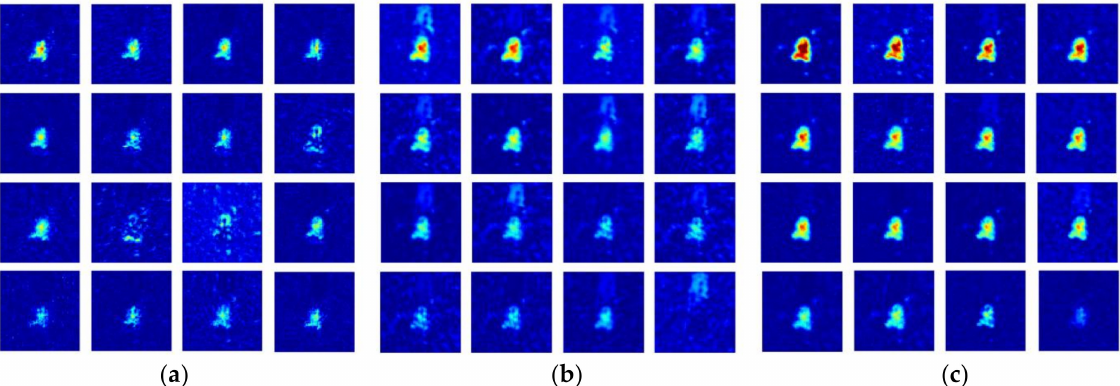
Figure 7. 16 strongest channel-wise activation maps of T72 SAR target image. ( a ) Activation maps from the basic CNN; ( b ) activation maps from the SE network; ( c ) activation maps from the DS-AE network.